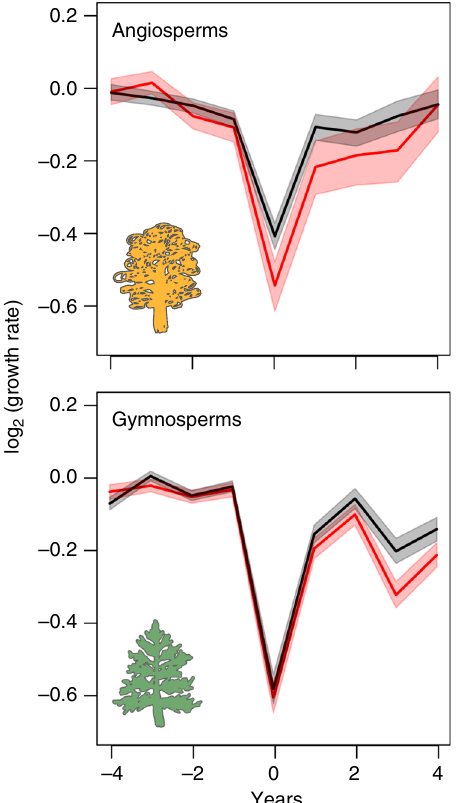
Fig. 3 Growth patterns before, during and after the drought event studied (year = 0) for angiosperms and gymnosperms. Data are presented as the average of log ratio between tree-ring width (TRW) at a given year and the average growth for the 4-year pre-drought period for surviving (black lines) and now-dead (red lines) trees. Shaded areas represent the 95% con fi dence intervals of the means from bootstrapping (1000 resamplings). Source data are available in Digital.CSIC repository (https://doi.org/ (Fig. 1), we do not fi nd consistent effects of aridity on growth resilience and its components. On the one hand, we fi nd a sig- ni fi cant positive interaction between tree status and aridity on resilience and, to a lower extent, on resistance (Table 1, Supple- mentary Fig. 6), suggesting that surviving trees in more humid sites are more resilient due to a better capacity to resist the initial drought impact. On the other hand, recovery is always inde- pendent from aridity, and aridity has no effect on resistance when BAI is used as a measure of growth instead of TRW (Supple- mentary Table 3). Recent large-scale studies reported that resis- tance increases with the ratio between soil moisture and PET, whereas resilience increases with precipitation 34,47 . Results con- cerning the recovery appear mixed, with slower 30 or faster 34,48 recovery in dry than in wet forests. These contrasting fi ndings may indicate that vulnerability to drought is to some extent decoupled from the exposure to climatic water de fi cits precisely because species distributions re fl ect (and tend to adjust to) the long-term climatic environment. Consistent with this view, hydraulic safety margins have been shown to be similar across biomes regardless of their rainfall environment 39 . Moreover, differences between studies could be explained by different biotic and abiotic conditions, experimental designs and modelling approaches. Overall, a universal pattern of the relationship between local climate and resilience remains hitherto inconclusive and deserves further investigation.